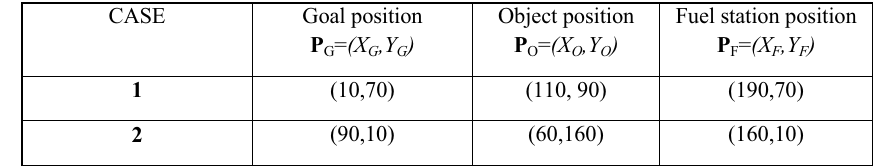
Table 3. Progress of the proposed algorithm for first set of fuels in problem case 1 in three different runs.